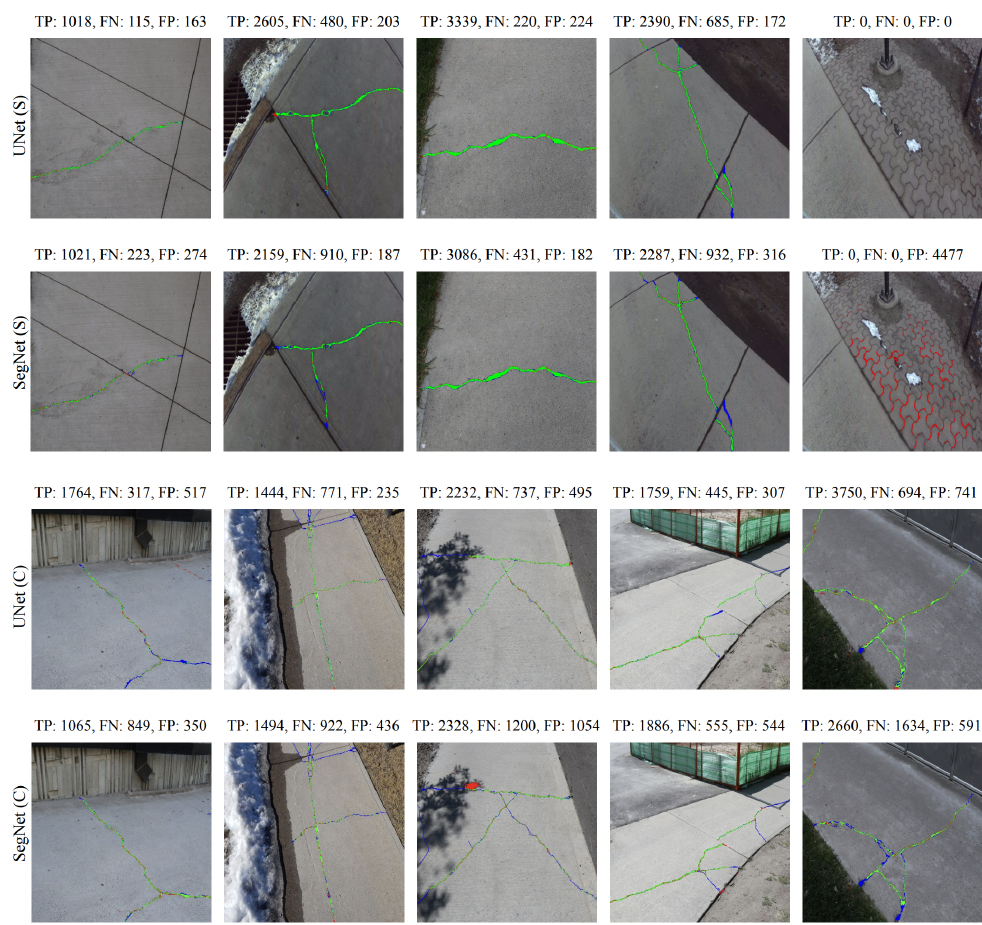
Figure 11. Best vs worst qualitative predictions—Best: UNet + Jaccard loss + traditional augmenta- tion + trained on patches and resized images; Worst: SegNet + BCE loss + no augmentation + trained with resized images and no patches. S: Simple, C: Complex, True Positives (TP): Green, False Positives (FP): Red, False Negatives (FN): Blue. The TP, FP, and FN number are displayed above each